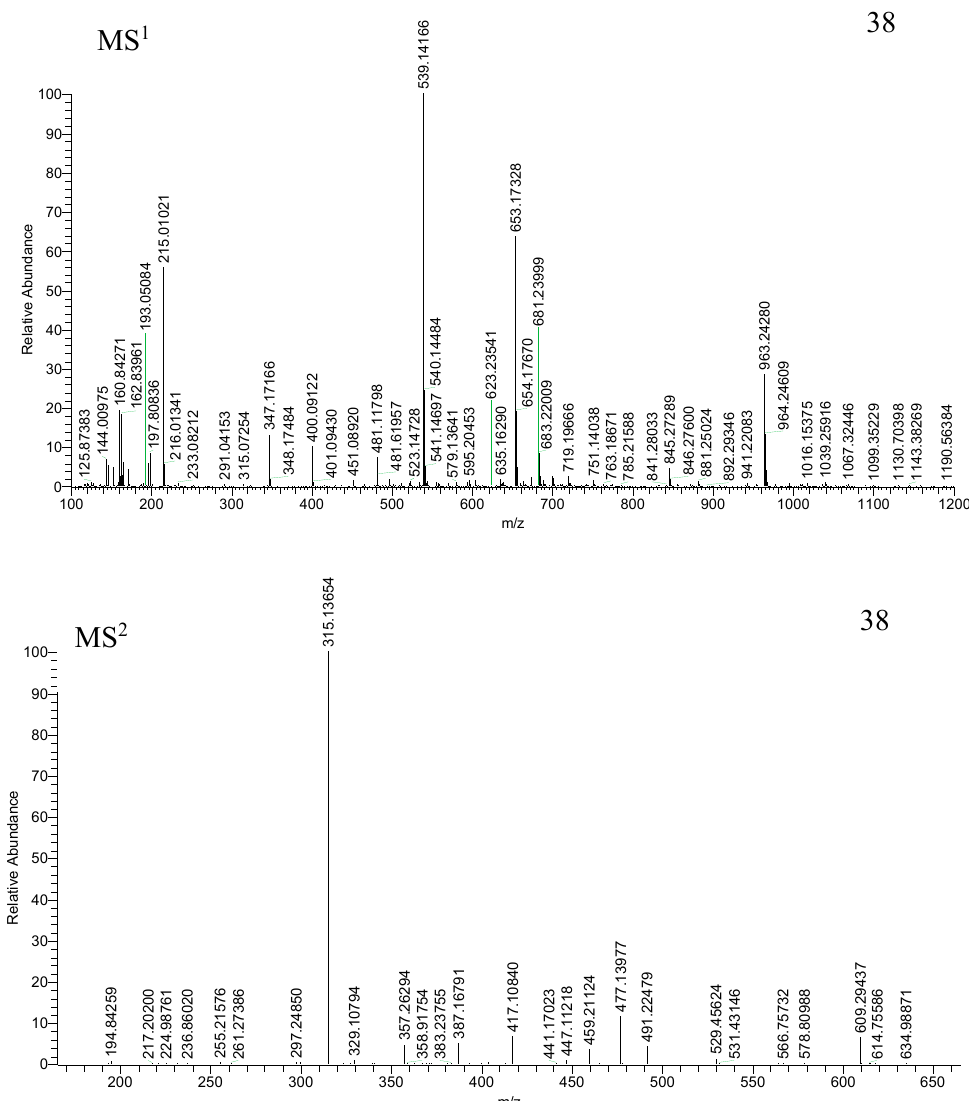
Figure 7. Spectra of ion fragments in MS n analysis of isovitexin-2 ′′ - O -B- D -glucosyle ( 16 ), saponarin ( 17 ), isovitexin, isopyrenine-7- O -glucosyle ( 38 ) in negative ion mode.